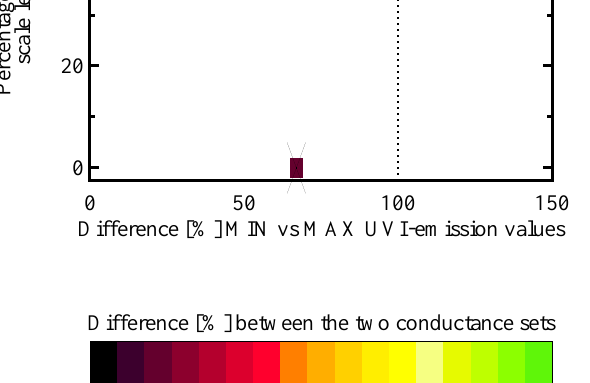
(selection (cid:0)